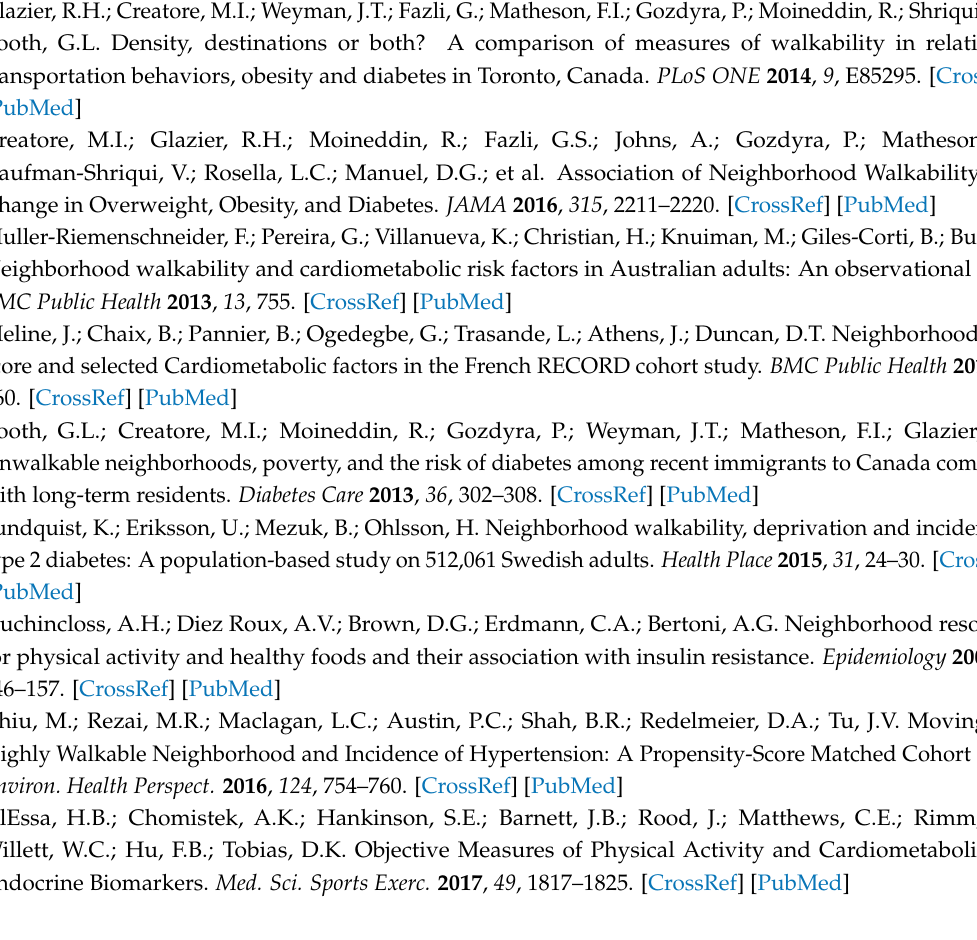
Participants from the Canadian Health Measures Survey